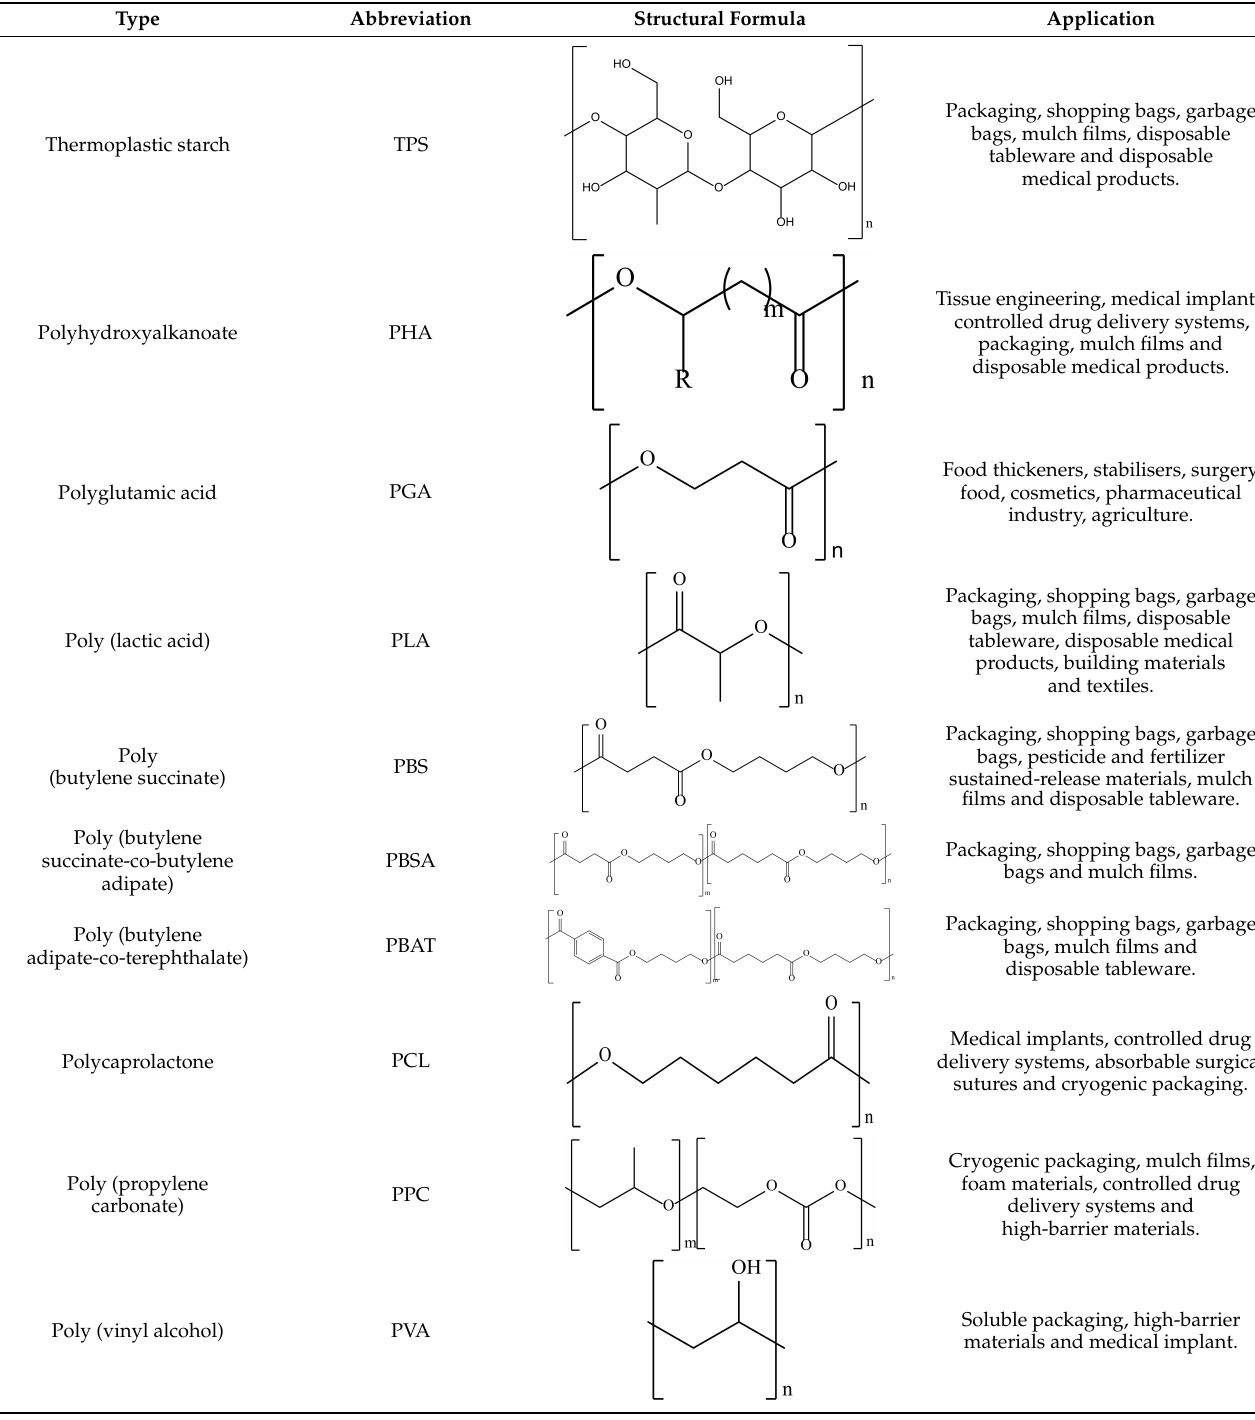
tableware and disposable medical products.